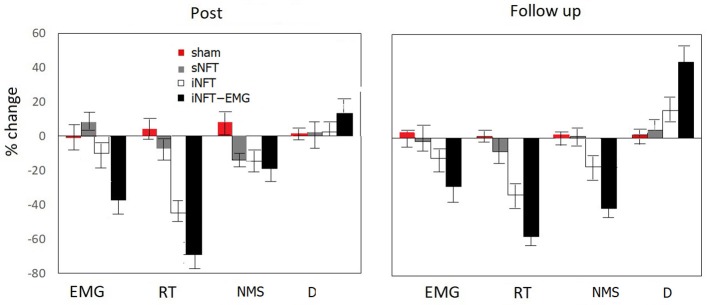
Mean and standard deviation of percentage change in EMG, reaction time (RT) and numbers of missed stimuli (NMS) in Go/no-Go task, as well as in duration of Delayed gratification task (D) at post-NFT session and six month after the NFT relative to the pre-NFT session.